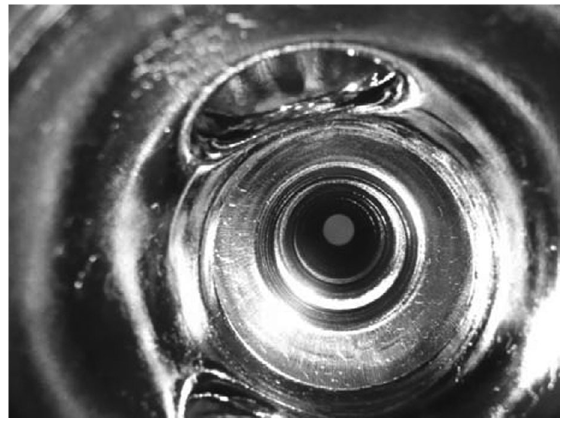
FIG. 20. Inside of a nine-cell Tesla-shape cavity (upper cells visible) after 4 hours (2 last hours at 17 L = min ) of VEP using a rod cathode at 6 V.